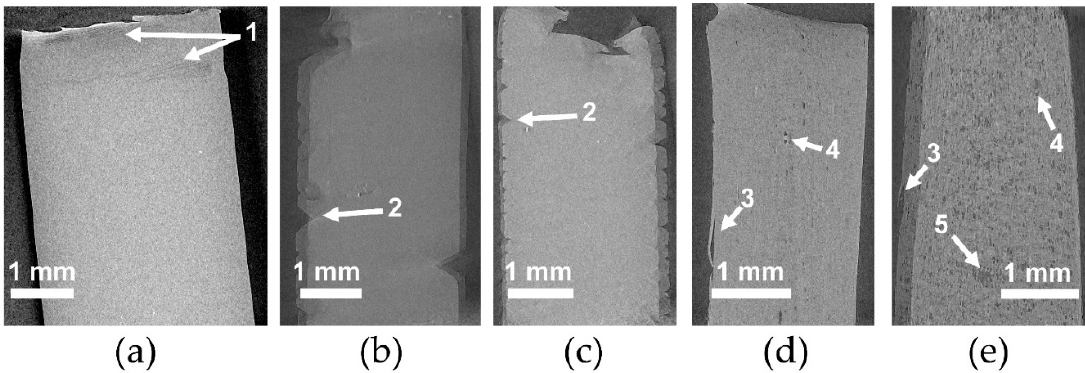
Figure 9. Representative 2D slices extracted from the reconstructed volume by micro-computed x-ray tomography (µCT) of broken tensile specimen of ( a ) polylactide (PLA), ( b ) PLA/limonene (PLA/LM), ( c ) PLA/LM/luperox 101 (PLA/LM/L101), ( d ) PLA/myrcene (PLA/My), and ( e ) PLA/My/luperox 101 (PLA/My/L101). 1: crazing, 2: cracking from the surface, 3: surface delamination, 4: plasticizer-matrix